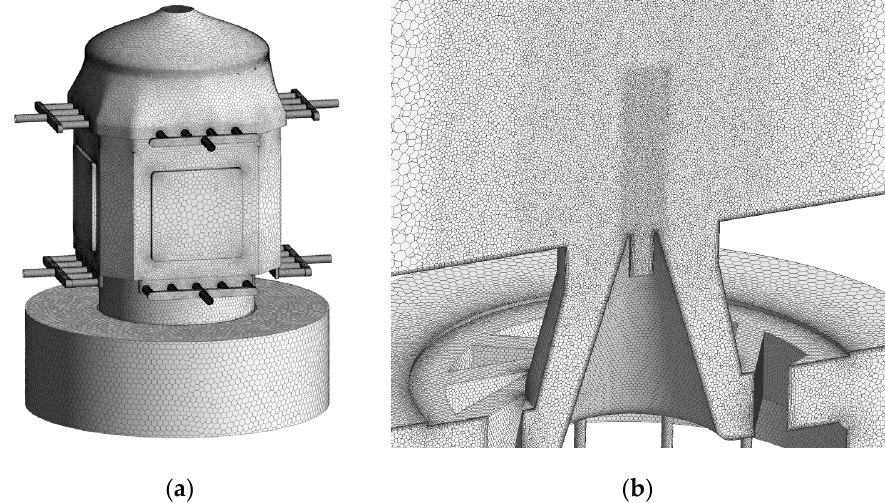
Figure 1. Computational mesh on the domain surface ( a ) and mesh in the section of the burner ( b ).